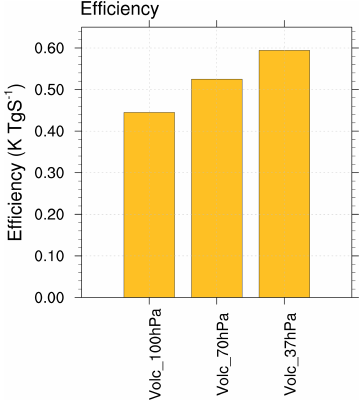
Figure 9. Change in global mean surface temperature per TgS in the stratosphere (efficiency) in the volcanic aerosol